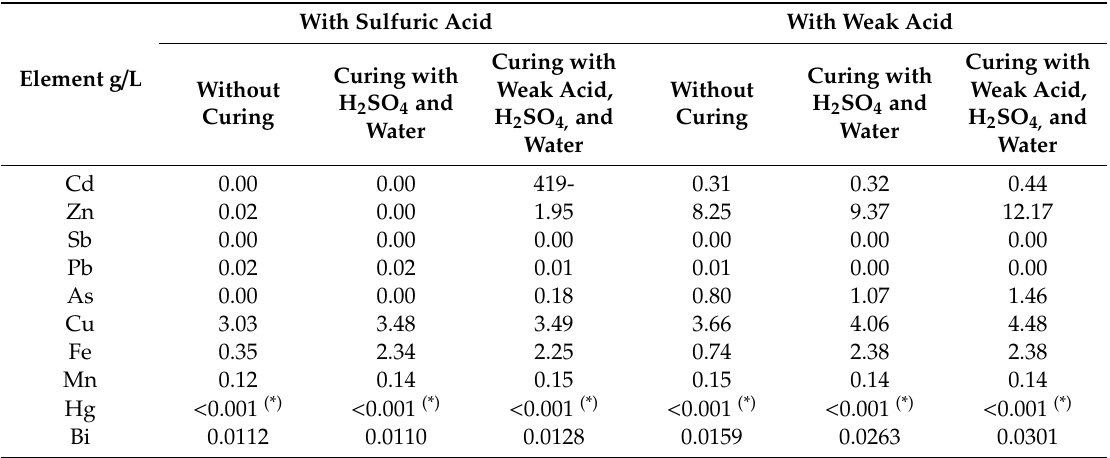
Table 6. Chemical characterization of the PLS obtained by leaching with sulfuric acid and weak acid.